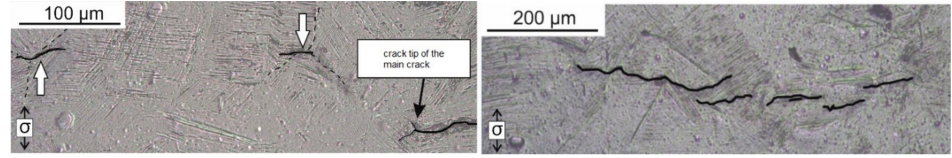
Figure 8. X2–12, Helium: Short cracks before grain boundaries cross coalescence; Crack initiation of multiple short cracks in front of the crack tip